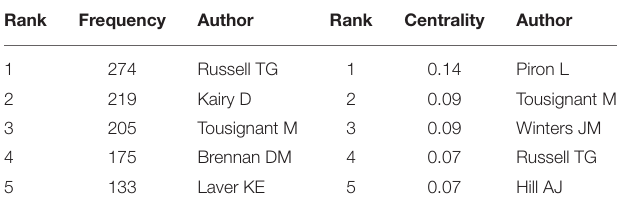
TABLE 5 | Top five Frequency and centrality of cited authors related to telerehabilitation. Rank